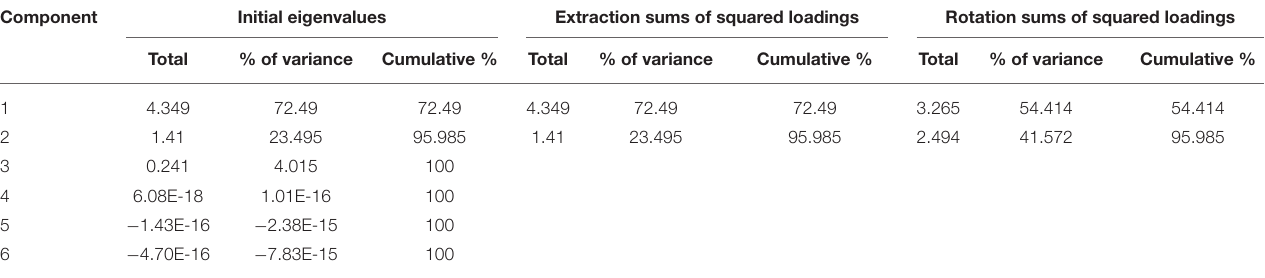
TABLE 10 | PCA total variance